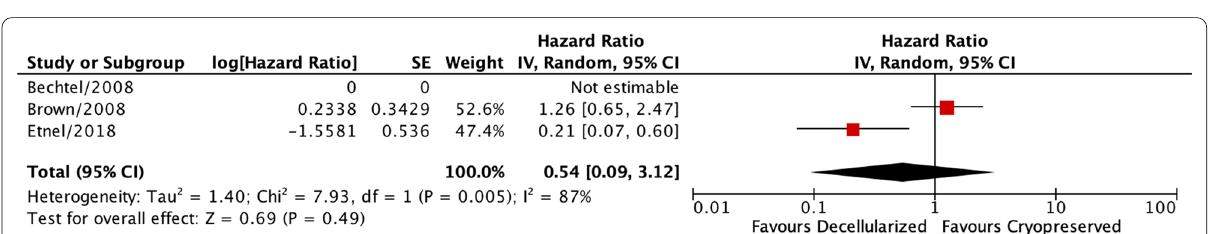
Fig. 4 Forest plot comparing reinterventions in decellularized allografts versus cryopreserved allografts for patients undergoing right ventricular outflow tract reconstruction during the Ross procedure. IV inverse variance, CI confidence